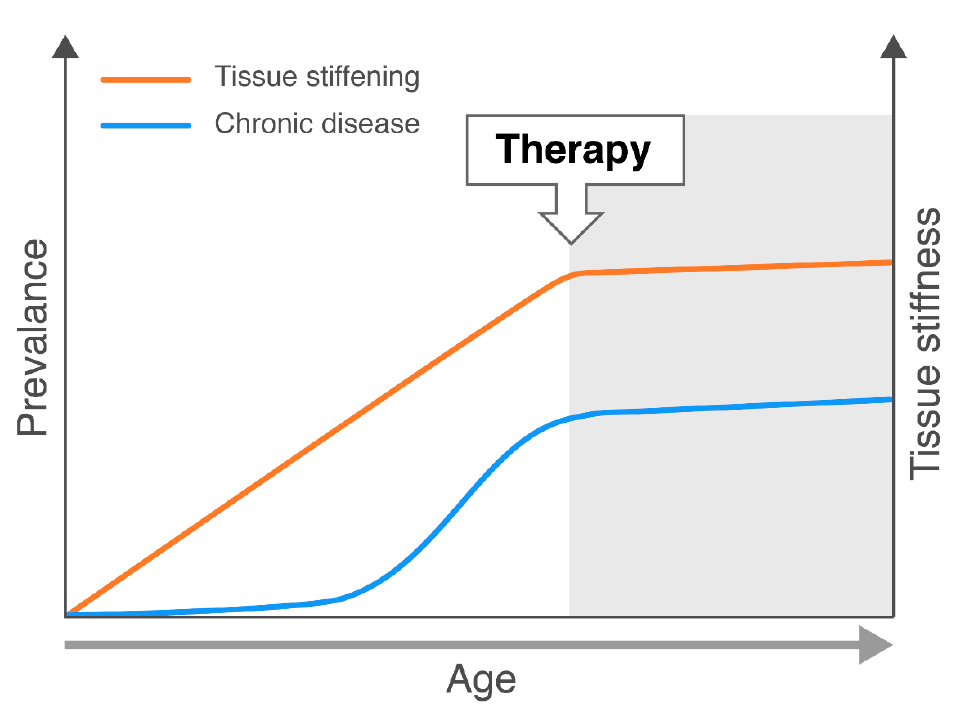
Figure 3. A hypothetical graph linking the effect of tissue stiffness with age and chronic disease. Upon therapy intervention which would target signalling cascades we would assume a correlation between less stiffness and chronic disease.